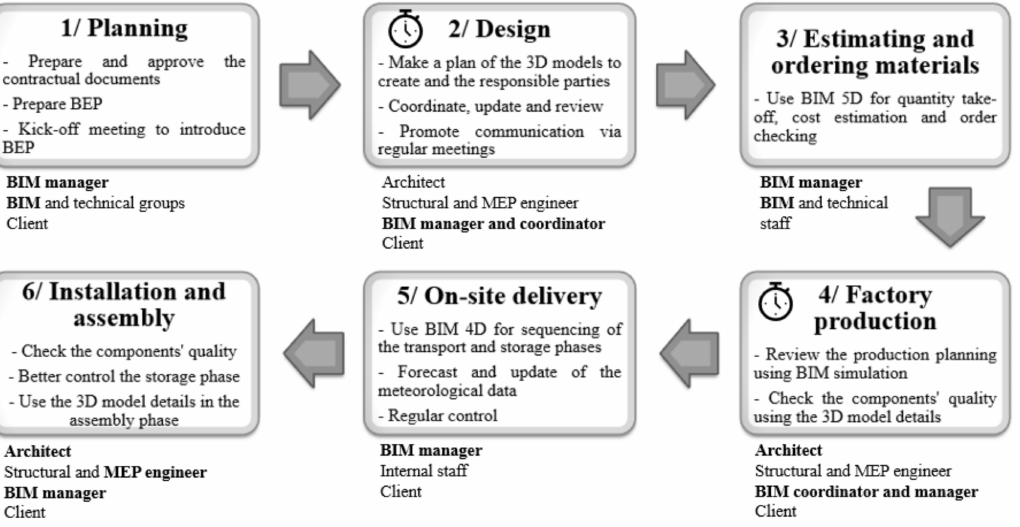
Figure 5. BIM implementation process at the project and team level for multi-housing projects conducted by an